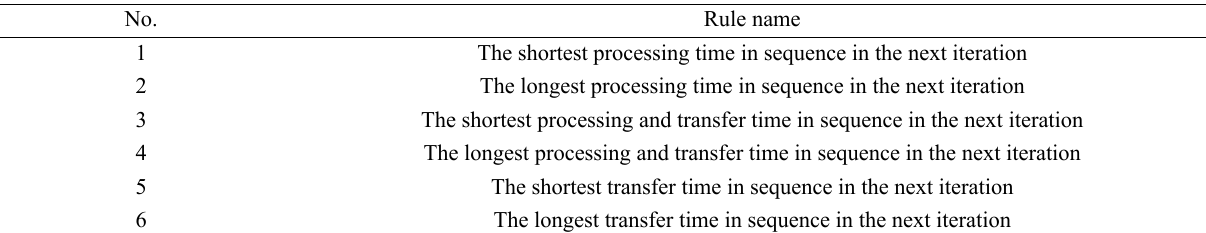
Table 1 Lower level action set.